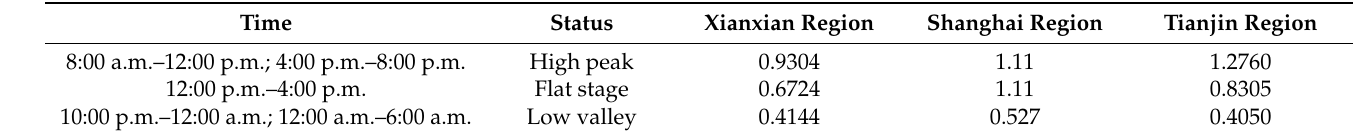
Table 3. Time-of-use electricity prices for three regions used in this study (CNY/kW · h). Time Xianxian